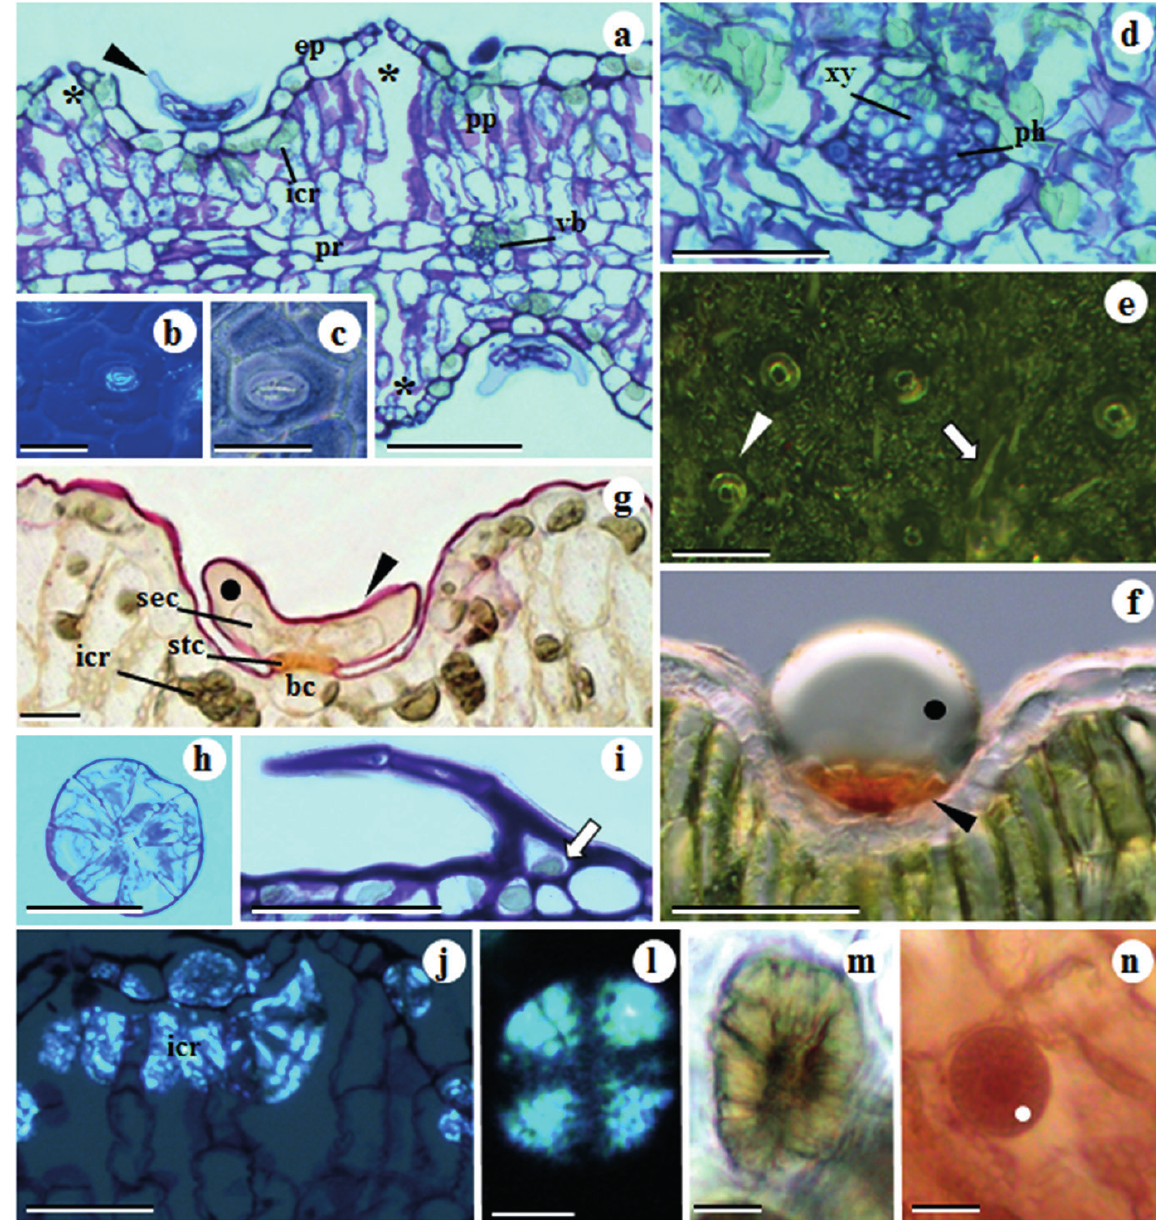
Figure 1 - Structural characterization of Hesperozygis ringens leaf blade. Figures 1a, d, f-g, i-n in transversal sections. Figures 1b-c and e in frontal view. Figure 1h in paradermal section. (a) Epidermis (ep), inulin crystal (icr), palisade parenchyma (pp), perpendicular parenchyma (pr), vascular bundle (vb), glandular trichome (arrow head), substomatic chambers (asterisks). (b) Detail of diallelocytic stomata. (c) Detail of diacytic stomata. (d) Detail of the vascular bundle, highlighting xylem (xy) and phloem (ph). (e) Leaf blade indumentum presenting glandular trichome (arrow head) and non-glandular trichome (arrow). (f) Detail of glandular trichome with a natural orange coloration (arrow head) and distended cuticle (black circle). (g) Detail of glandular trichome (arrow head) stained by Sudan Red 7B, highlighting inulin crystal (icr), basal cell (bc), stalk cell (stc), secretory cell (sec) and distended cuticle (black circle). (h) Detail of glandular trichome presenting eight secretory cells. (i) Detail of non-glandular trichome and inulin crystal (arrow). (j) Inulin crystal (icr) under polarization. (l) Detail of inulin crystal under polarization presenting a shape of maltese cross. (m) Detail of inulin crystal presenting streaks after dehydration period. (n) Detail of reddish precipitate (circle) after floroglucine reaction. Scale bars: 20 µm (l, m and n) ; 50 µm (b, c, d, h, i and j) ; 100 µm (a, f and g) ; 500 µm (e)